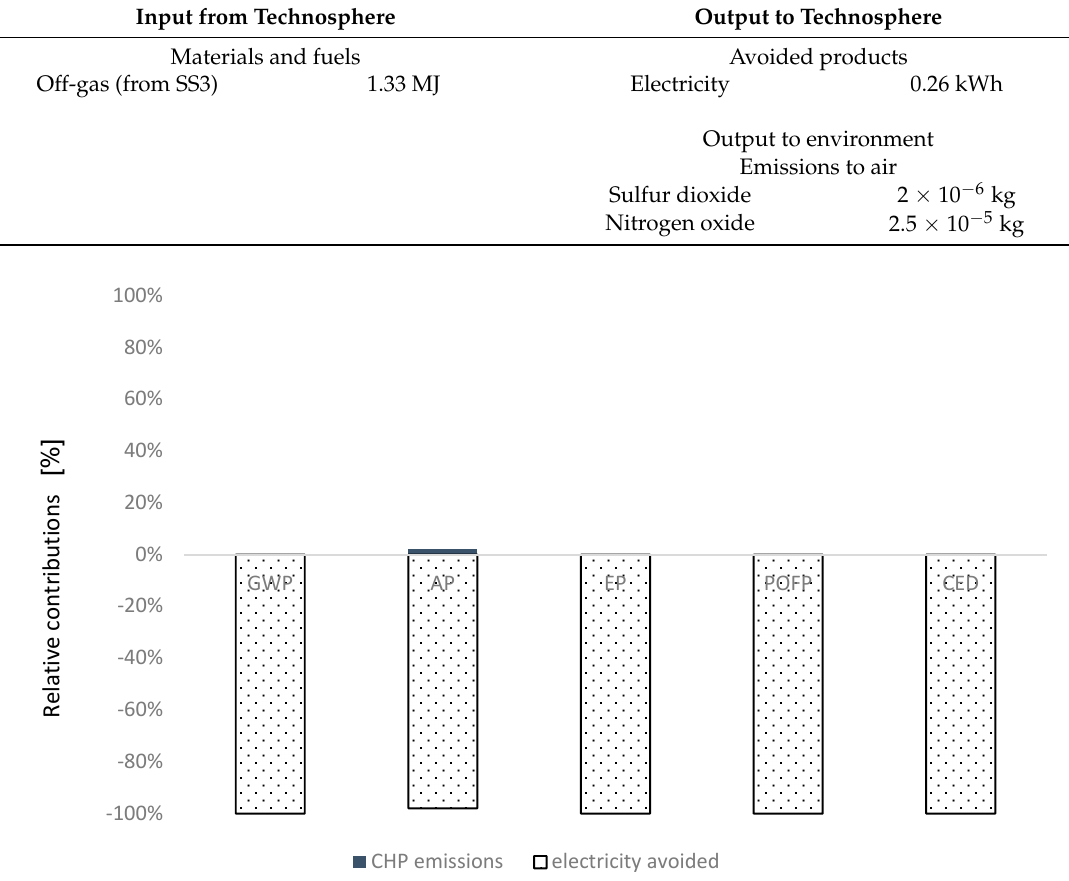
Figure 6. Breakdown of contributions from process involved in Subsystem 4.